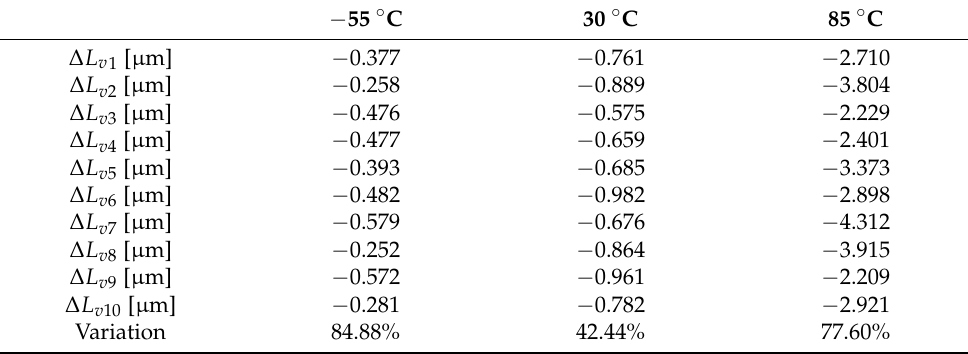
Table 2. Results of creep deformation of ER.